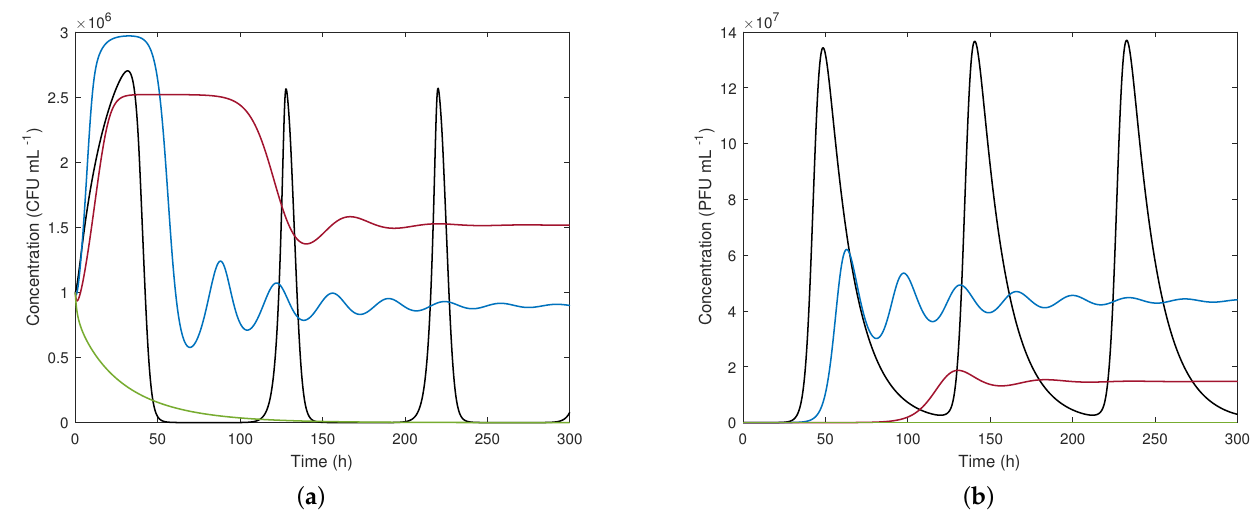
Figure 5. Time evolution for different dilution rates. ( a ) Susceptible bacteria. ( b ) Phages. Initial conditions X S 0 = 1 × 10 6 CFU mL − 1 , X I 0 = 0, P 0 = 1 × 10 2 PFU mL − 1 and S 0 = 0.1 mg mL − 1 . Dilution rate: black line D = 0.05 h − 1 , blue line D = 0.2 h − 1 , red line D = 0.3 h − 1 , and green line D = 0.42 h − 1